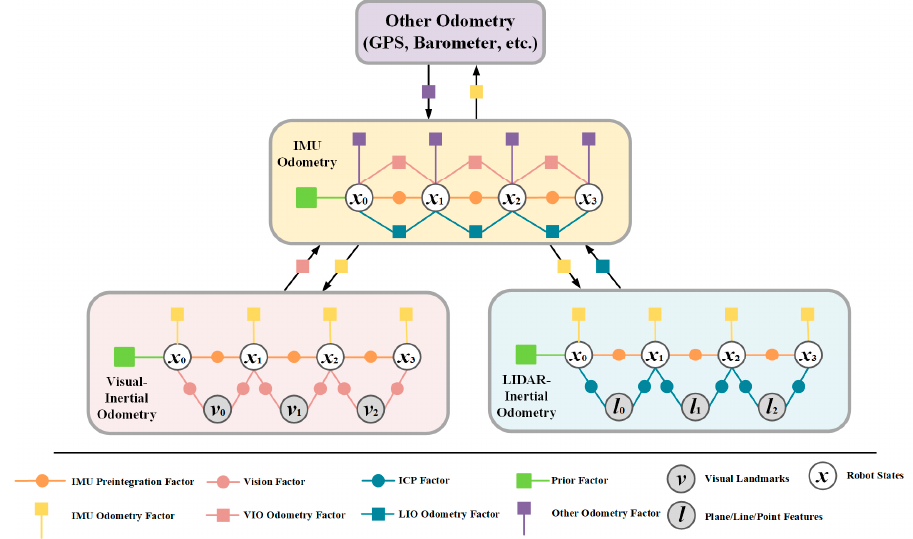
Figure 7. Factor graph structure of Super Odometry.